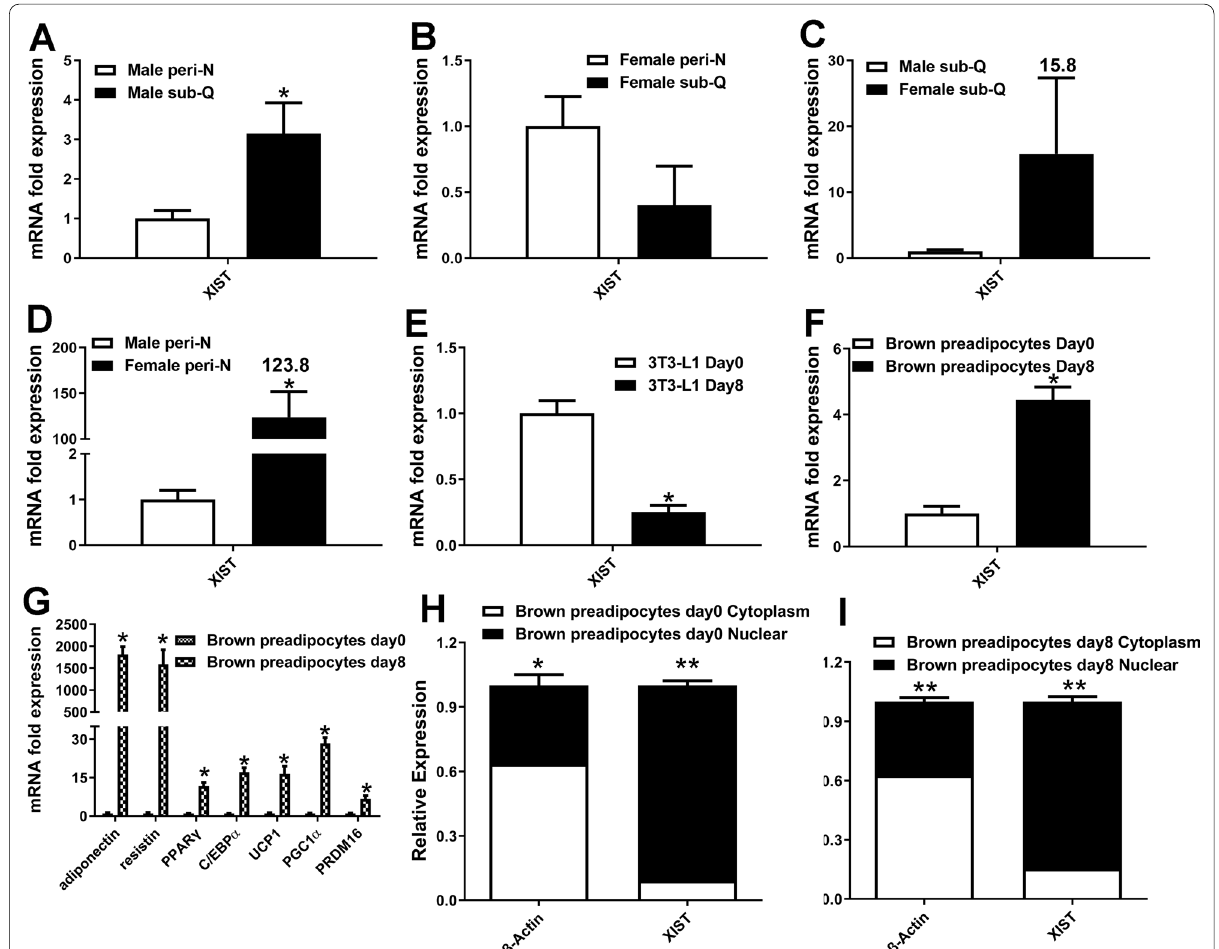
Fig. 1 XIST expression in human adipose tissues and preadipocytes. A – D qRT-PCR analyses of XIST expression in human perirenal and subcutaneous adipose tissues. E mRNA level of XIST in white (3T3-L1) preadipocytes. F – G qRT-PCR analyses of XIST and indicated genes in brown preadipocytes. H – I Subcellular localization of brown preadipocytes. Male: male patients, n adipose tissue; sub-Q: subcutaneous adipose tissue. Day 0: undifferentiated adipocytes; day 8: differentiated adipocytes. *, p < 0.05; **, p < 0.01. Data are represented as mean ±